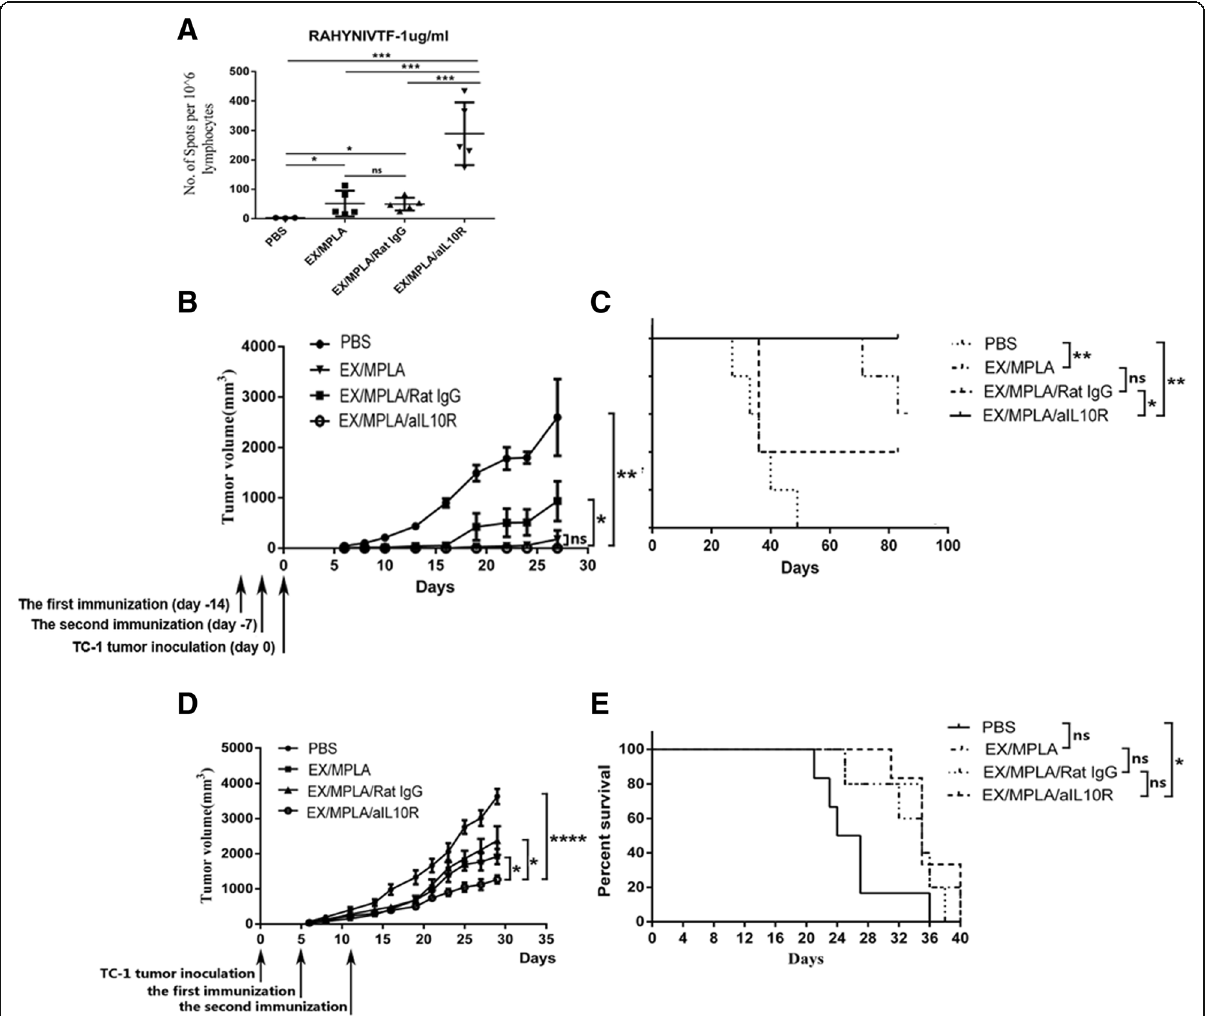
Fig. 1 Blocking IL-10 at the time of immunisation does not increase the survival time of TC-1 tumour bearing mice a Groups of five C57BL/6 mice were primed and boosted on day 0 and day 7 respectively with 40 μ g of Ex peptides (each 10 μ g), 15 mg of MPLA and 250 μ g of anti-IL10 receptor antibodies or IgG Isotype control antibody subcutaneously. Seven days after final immunisation, spleens from immunized mice were collected, single spleen cells isolated and cultured in the presence of an MHC I restricted HPV16 E7 specific peptide RAHYNIVTF. ELISPOT assay for IFN γ was performed as described in Materials and Methods. b, c Groups of five C57BL/6 mice were immunized with 40 μ g of Ex peptide, 15 mg of MPLA and 250 μ g of anti-IL10 receptor antibodies or IgG isotype control antibody subcutaneously or left unimmunized on day zero and seven. Seven days after immunization, 2 × 10 5 of TC-1 tumour cells were inoculated subcutaneously in the flank of immunized or unimmunised mice, and tumour size and survival of mice were monitored as described in Materials and Methods. (D, E) Groups of eight C57BL/6 mice were inoculated subcutaneously in the flank with 2×10 5 of TC-1 tumour cells. 5 days later, mice were immunized with 40mg of Ex peptide, 15mg of MPLA and 250 μ g of anti-IL10 receptor antibodies or IgG isotype control antibody subcutaneously or left unimmunized twice 7days apart. Survival of mice was monitored as described in Materials and Methods. The results represent at least one of two independent